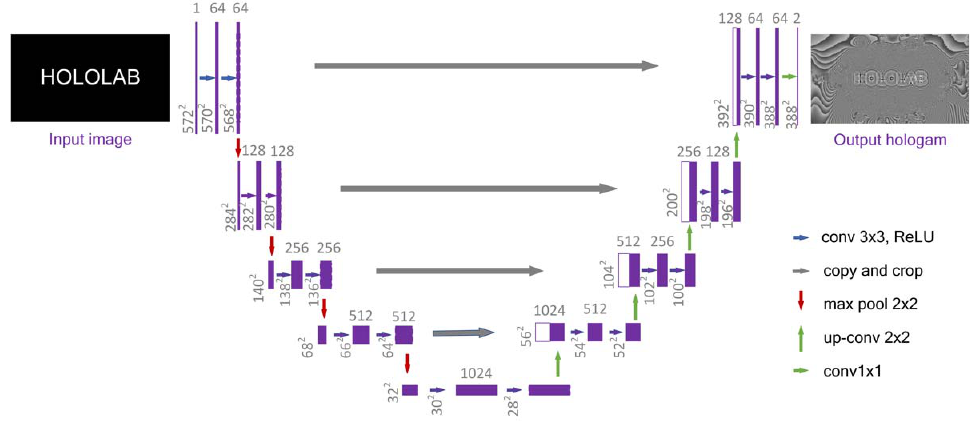
Figure 2. Structure of the U − Net neural network.